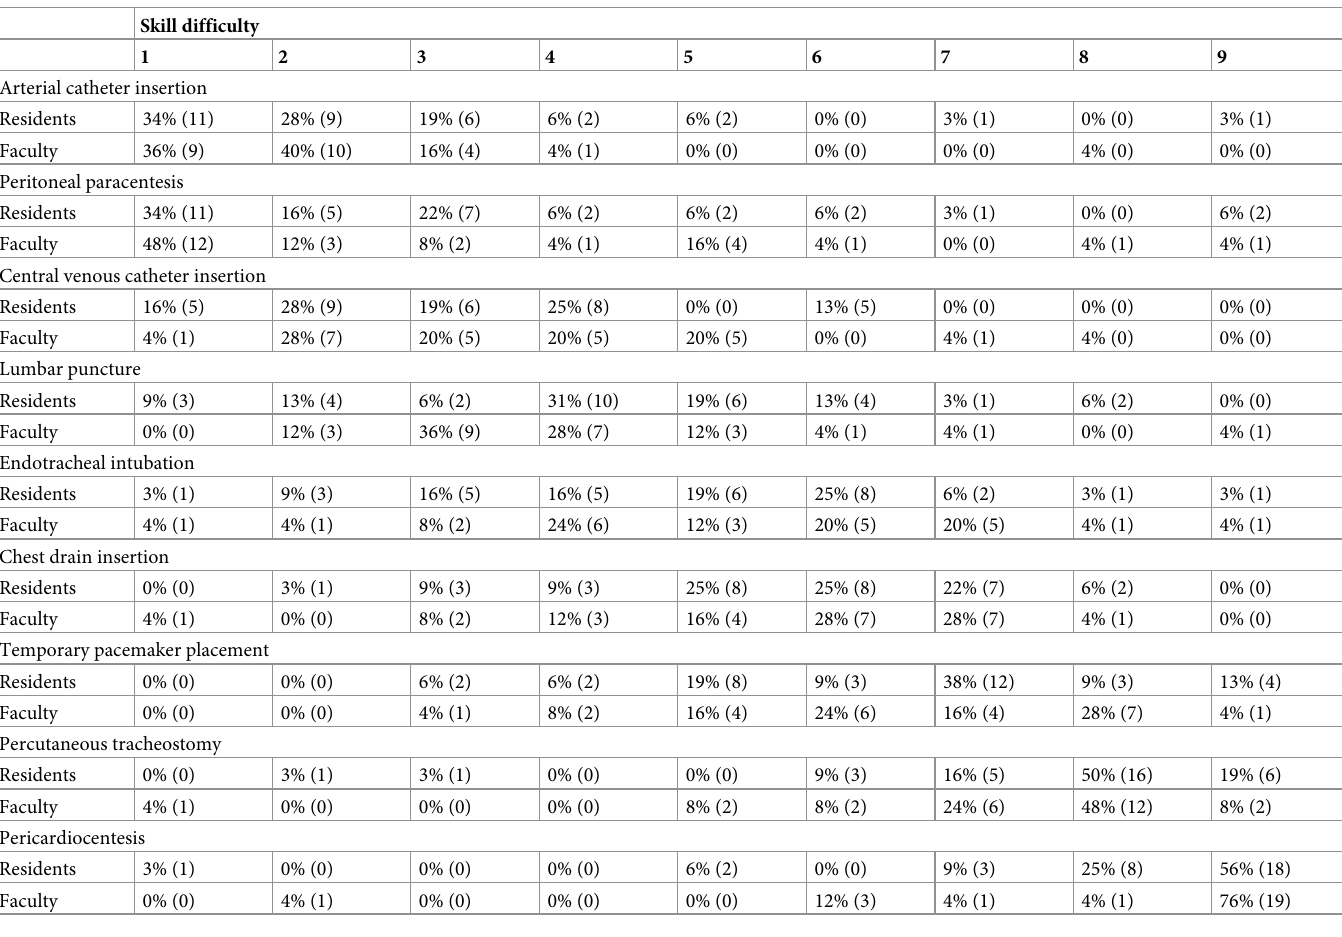
Table 4. Distribution of skill difficulty ranking by residents and